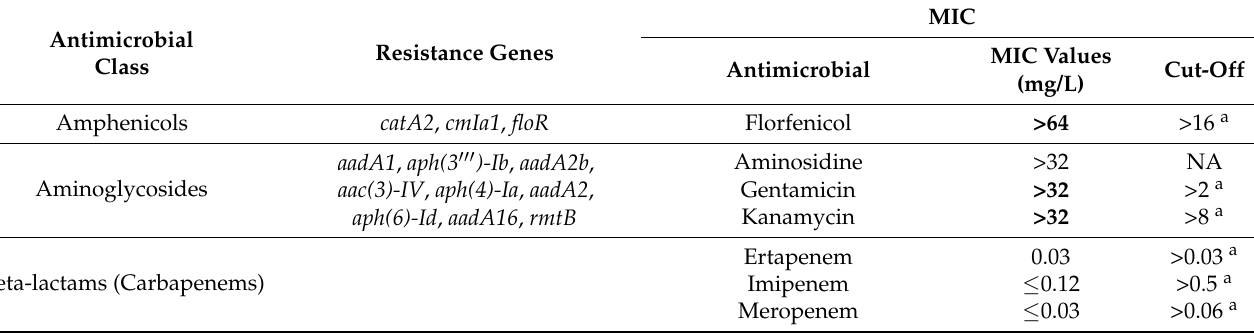
Table 1. Resistance genes detected by WGS in E.coli_MDRbs22 isolated from a pig, corresponding minimum inhibitory concentrations (MICs) and applied cut-offs for the tested antimicrobials. Resistances are highlighted in bold.